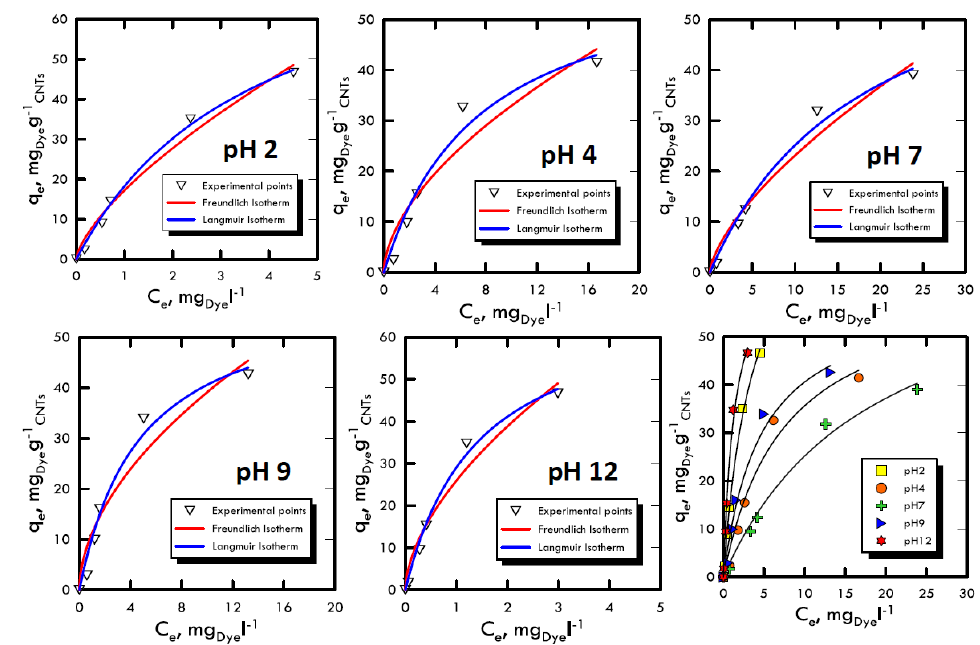
ff erent pH values.